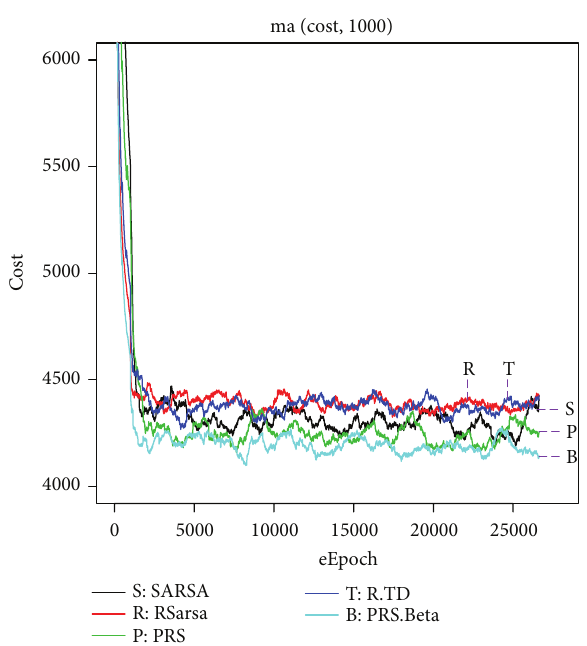
Figure 5: Moving average of period costs, P2.